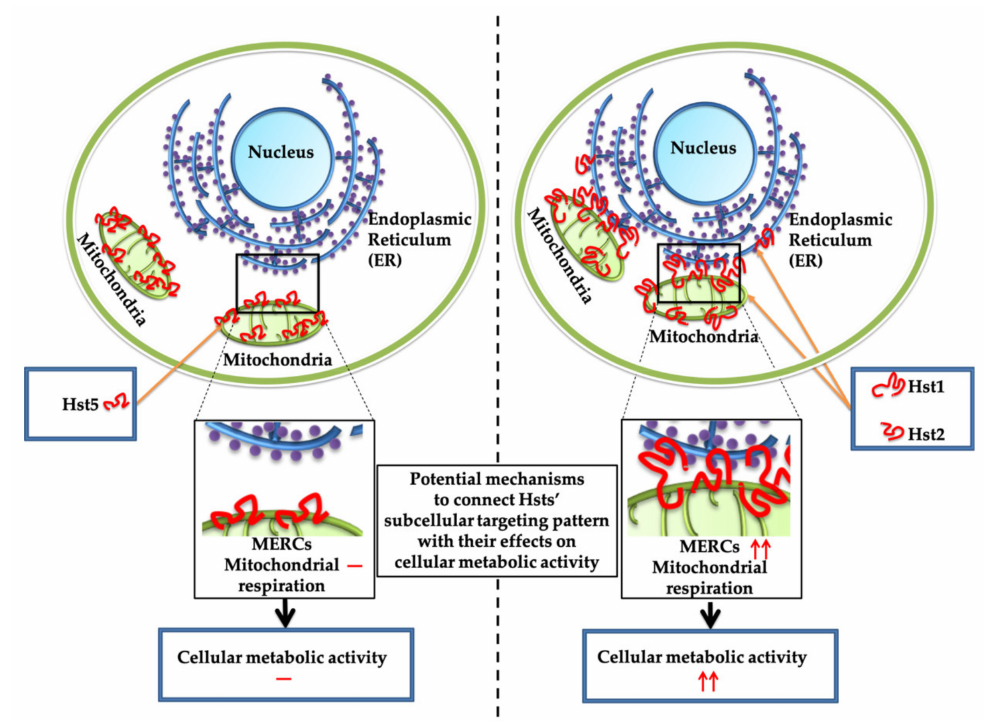
Figure 11. A schematic representation of cell-activating Hst1 and Hst2, which have a di ff erent subcellular targeting pattern compared to non-cell-activating Hst5. Hst1 and Hst2 co-localize with both mitochondria and ER, while Hst5 co-localizes with mitochondria but not ER. Such a subcellular targeting pattern of Hst1 and Hst2 may potentially enhance mitochondria-ER contacts (MERCs), thereby promoting mitochondria respiration and cellular metabolic activity. In contrast, Hst5 cannot regulate MERCs, thus showing no e ff ect on cellular metabolic